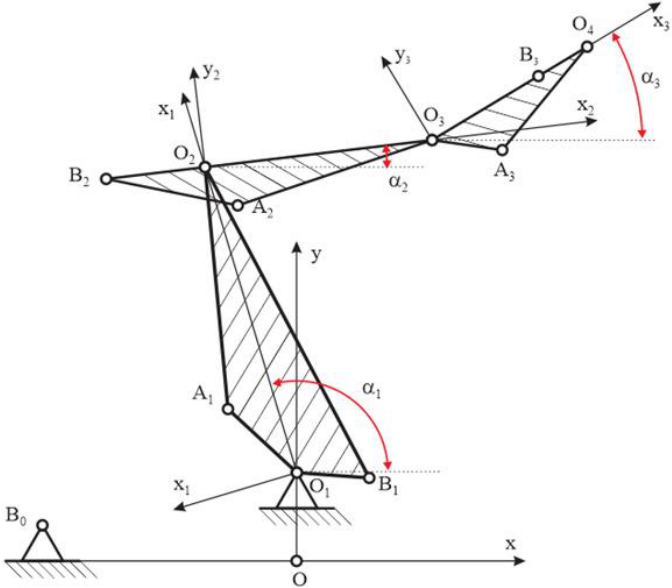
Figure 7. Schematic representation of the angular measuring system.